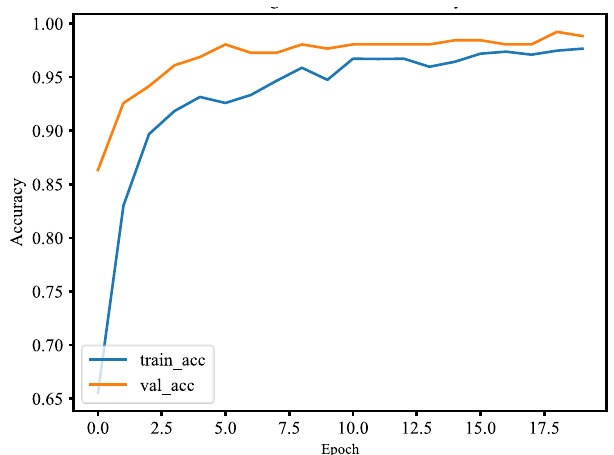
Figure 31. Loss of mask wearing detection.